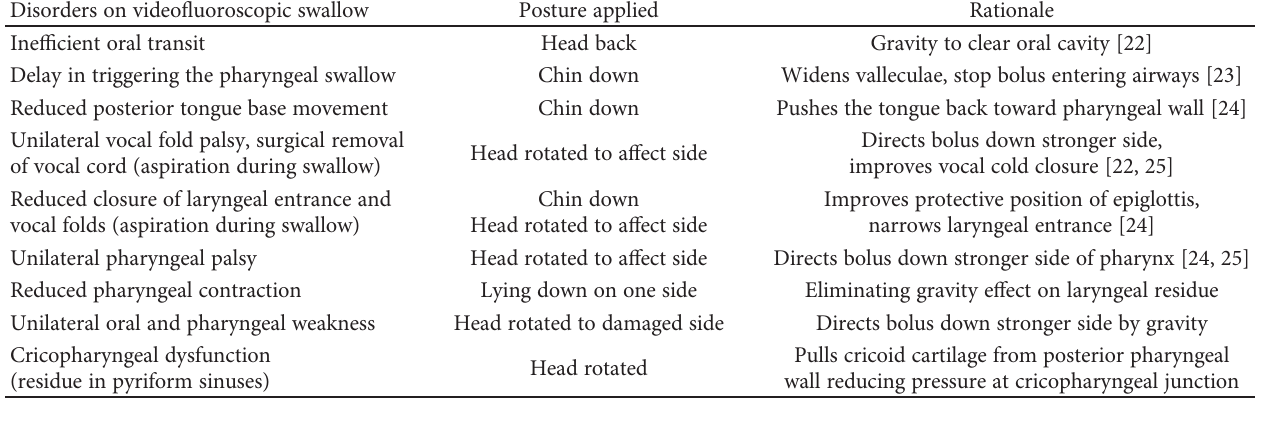
Table 4: Postures used for eliminating aspiration or residue, the disorders they are designed to address, and the rationale for their use [19, 21].